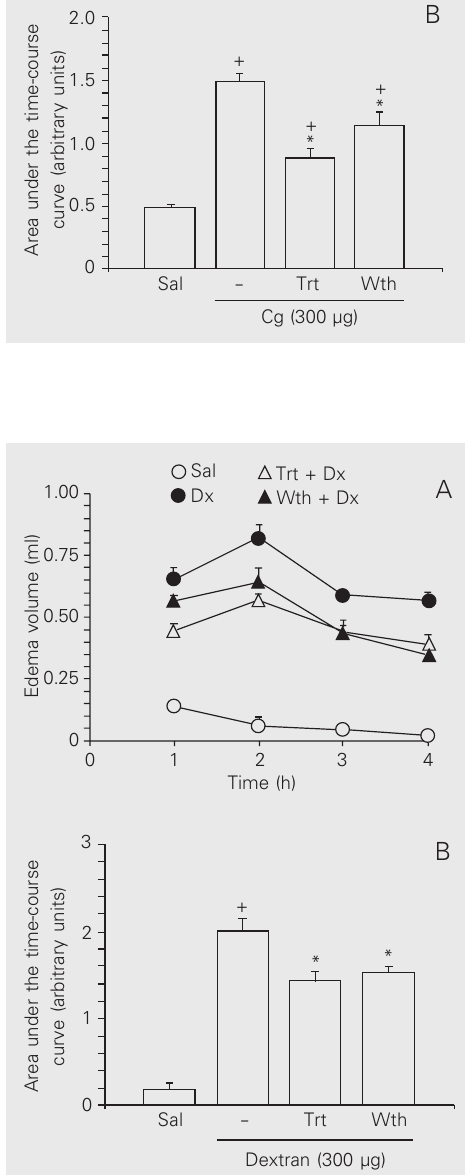
Figure 1. Effect of ethanol inhala- tion on paw edema induced by carrageenan. Rat paw edema was induced by intraplantar in- jection of carrageenan (Cg, 300 µg/0.1 ml) in animals exposed to ethanol vapor for 10 days (intoxi- cated or treated group, Trt) and animals pretreated with ethanol and submitted to 7 h of with- drawal (withdrawn group, Wth).